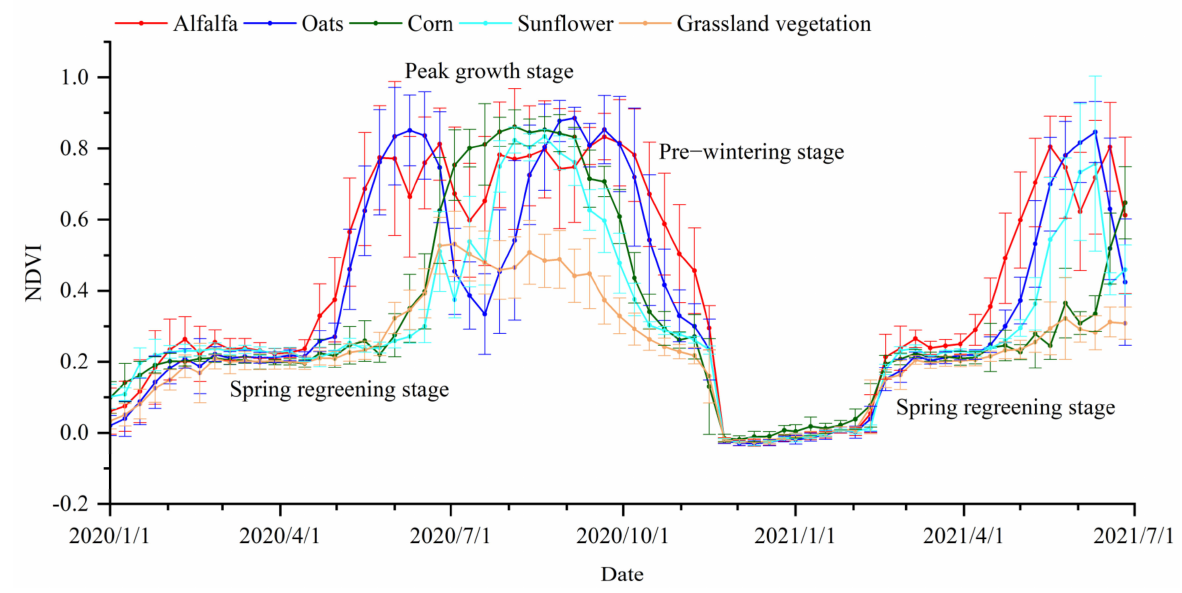
Figure 2. NDVI values of different vegetation types derived from the MODIS data from January 2020 to June